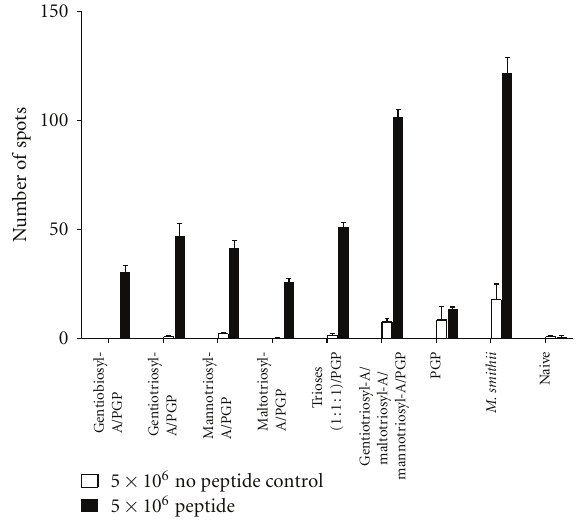
Figure 2: Antigen-specific CD8 + T cell activity in splenic cells of immunized mice as assayed by Elispot. Ratios of lipids in mol% for various compositions of archaeosomes were: di or triglycosylarchaeols/PGP (45/55), and gentiotriosyl- A/maltotriosyl-A/mannotriosyl-A/PGP (15/15/15/55), where “A” refers to archaeol. Trioses (1:1 :1)/PGP refers to admixed triglycosyl-A/PGP vaccines, such that each contributed equal amounts of antigen. M. smithii represents OVA-loaded archaeo- somes consisting of total polar lipids from M. smithii , as pos- itive control. Mice were immunized subcutaneously at 0 and 3 weeks with OVA-loaded archaeosome adjuvants. Nonimmunized mice (naive) were included as negative controls. Spleens from duplicate mice were collected 5.5 weeks after first injection to determine the frequency (number of spots) of interferon- gamma (IFN- γ )-secreting splenic cells (spots) by enzyme-linked immunospot assay (Elispot). Omission of the major CD8 epitope of OVA (SIINFEKL) from the assay (no peptide control) was used to test for nonspecific responses. Means significantly di ff erent ( P < 0.05) were gentiotriosyl-A/PGP versus maltotriosyl-A/PGP ( P = 0.0204), mannotriosyl-A/PGP versus maltotriosyl-A/PGP ( P = 0.0135), and maltotriosyl-A/PGP versus PGP ( P = 0.0032). Those not significantly di ff erent were gentiotriosyl-A/PGP ver- sus mannotriosyl-A/PGP ( P = 0.4238), gentiotriosyl-A/PGP versus gentiobiosyl-A/PGP ( P = 0.0550), mannotriosyl-A/PGP versus gentiobiosyl-A/PGP ( P = 0.0677), and gentiotriosyl-A/maltotriosyl- A/mannotriosyl-A/PGP versus M. smithii ( P =